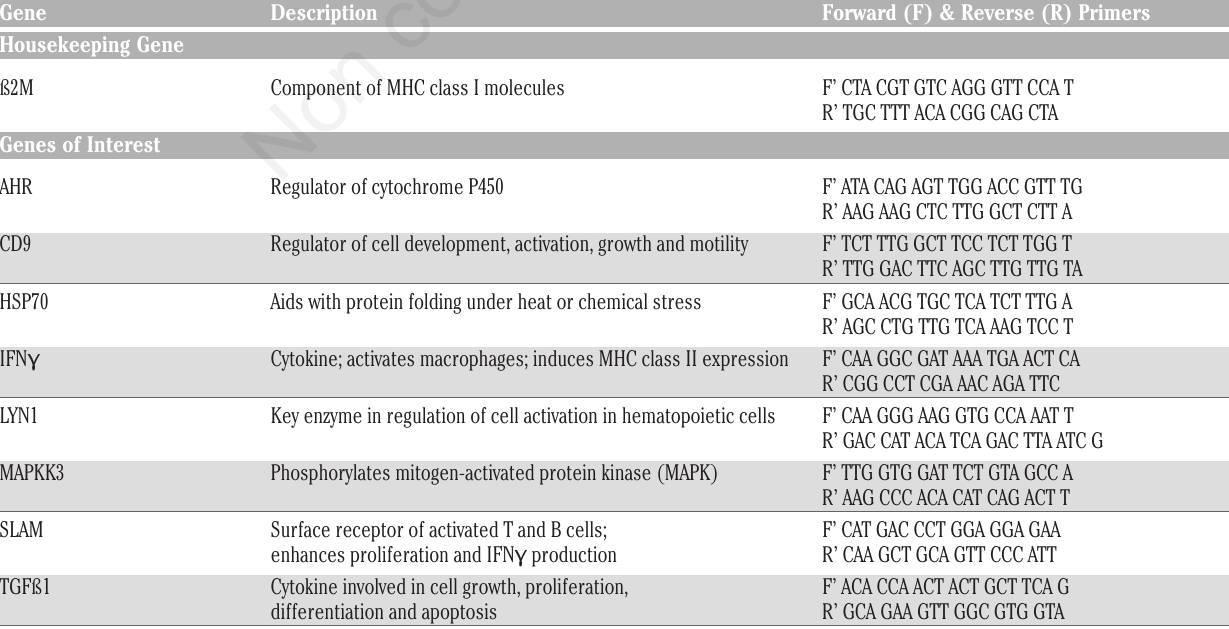
Table 1. Primers used for qPCR analysis. All primers are listed from 5’ to 3’. Gene Description Forward (F) & Reverse (R) Primers Housekeeping Gene ß2M Genes of